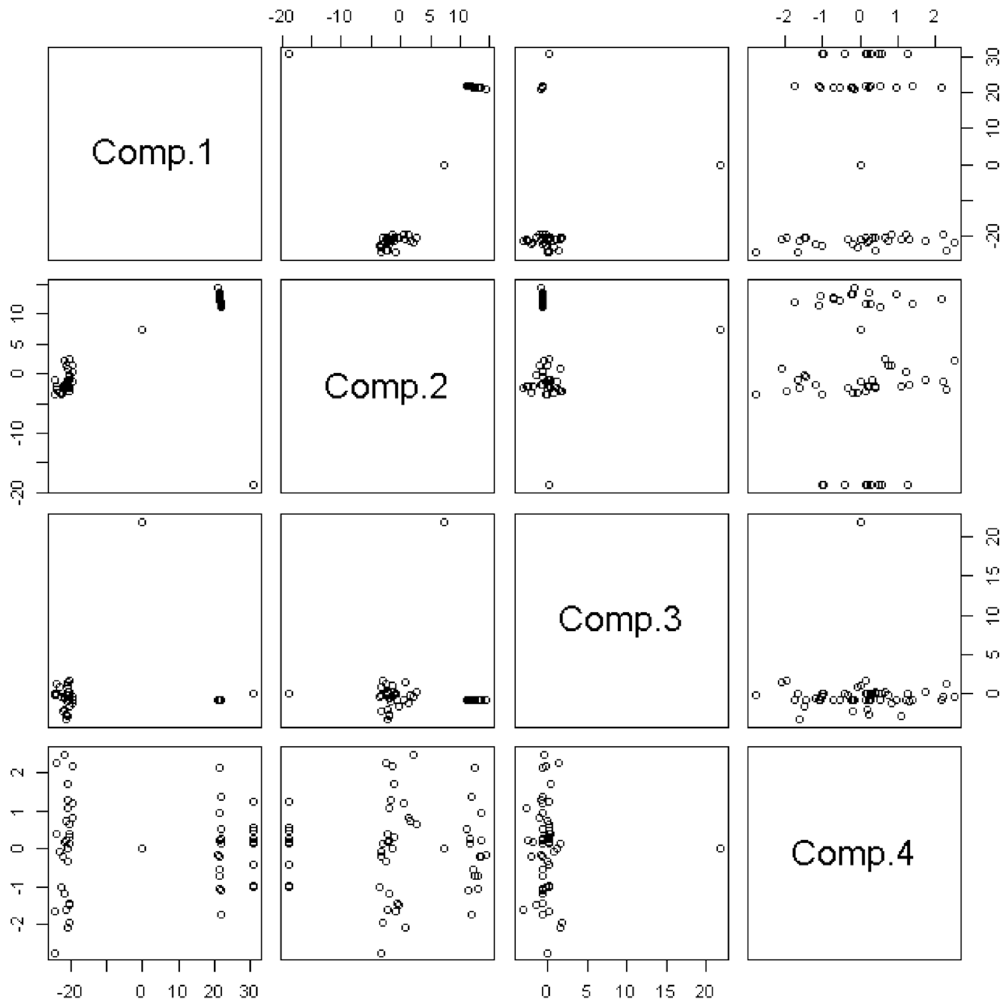
Figure 6. PCA analysis for Group HP + FM, Group FM, Group HP and Group